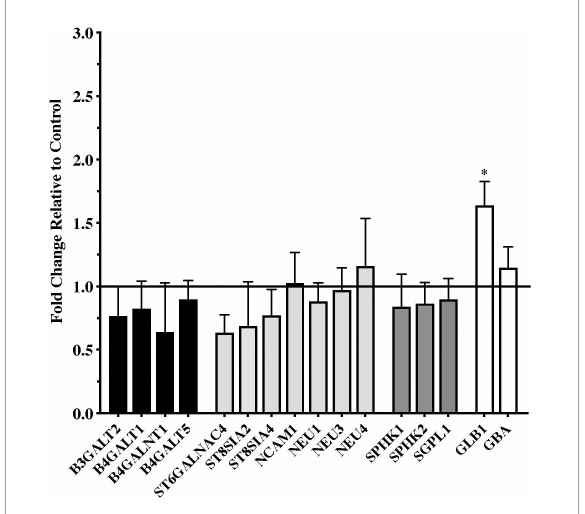
FIGURE2 Gene expression changes in putamen from patients with Parkinson’s disease ( N = 18) relative to normal, age-matched controls ( N = 13). Data are presented as fold change relative to control. In contrast to the numerous changes in gene expression observed in the PD substantia nigra, expression of only one of the genes examined, the lysosomal hydrolytic enzyme β -Galactosidase ( GLB1 ), was significantly altered in the PD putamen. * P < 0.05 vs.